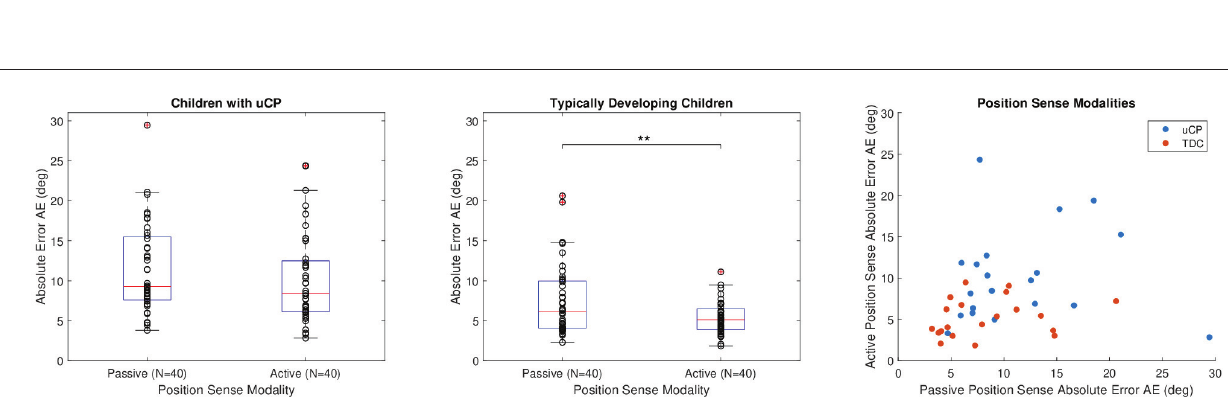
FIGURE 6 | Comparison between passive and active position sense for uCP and TDC. The stars indicate the following significance: ** < 0.01. Data from both hands and test sessions are considered together in the box plots ( N = 40). In the correlation plot, data from test session only and for both hands is considered ( N = 20 for each